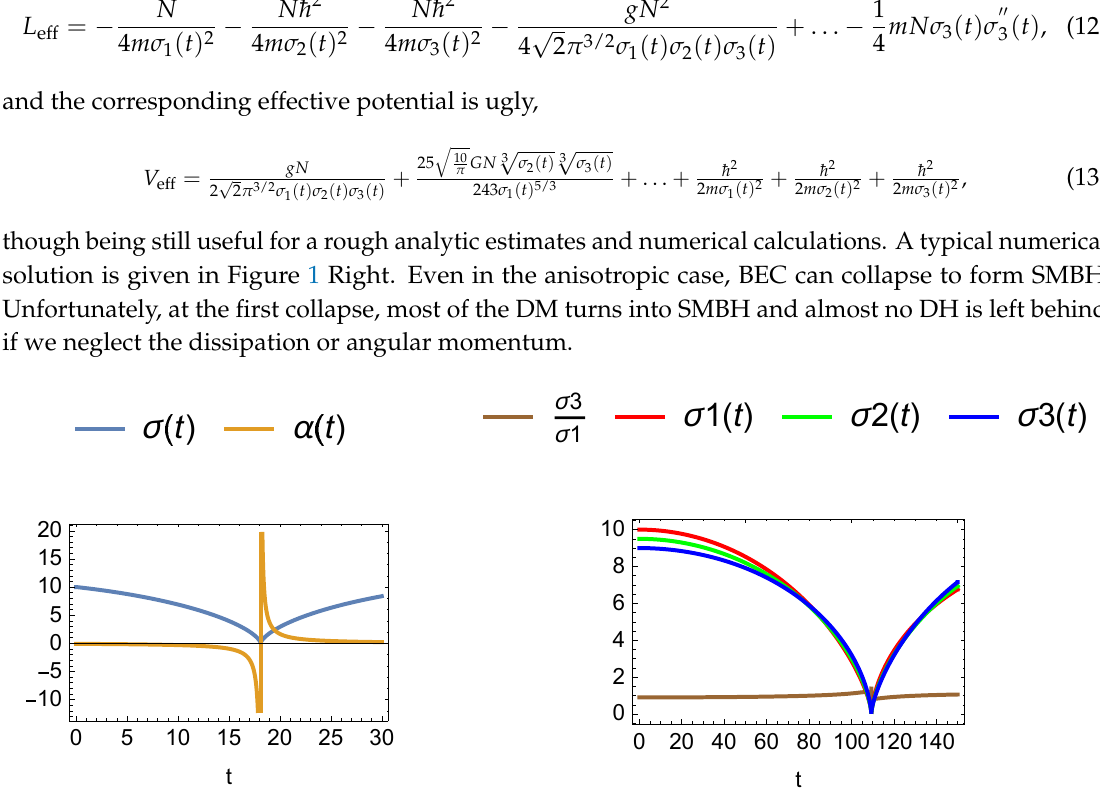
Figure 1. Time evolution of the typical collapsing dynamics of BEC. ( Left ) Isotropic collapse. The time evolution of the dispersion σ ( t ) and the phase α ( t ) of the condensate filed. If the minimum size σ min is smaller than the corresponding Schwarzschild radius, a BH is formed, otherwise it simply bounces. ( Right ) Anisotropic collapse. The time evolution of the dispersion σ i ( t ) and the ratio σ 3 ( t ) / σ 1 ( t ) of the condensate filed. Anisotropic BEC can easily collapse to form BH as